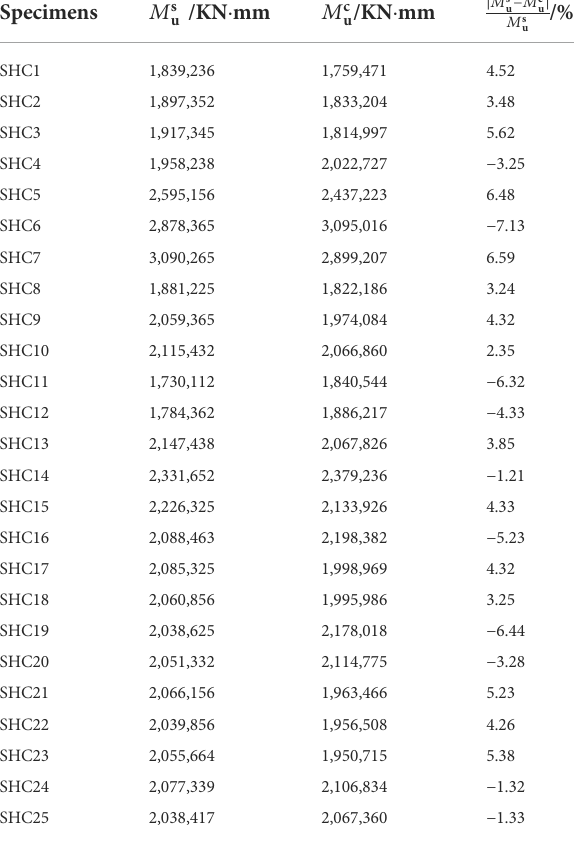
TABLE 5 Comparison between M s u and M c u of 25